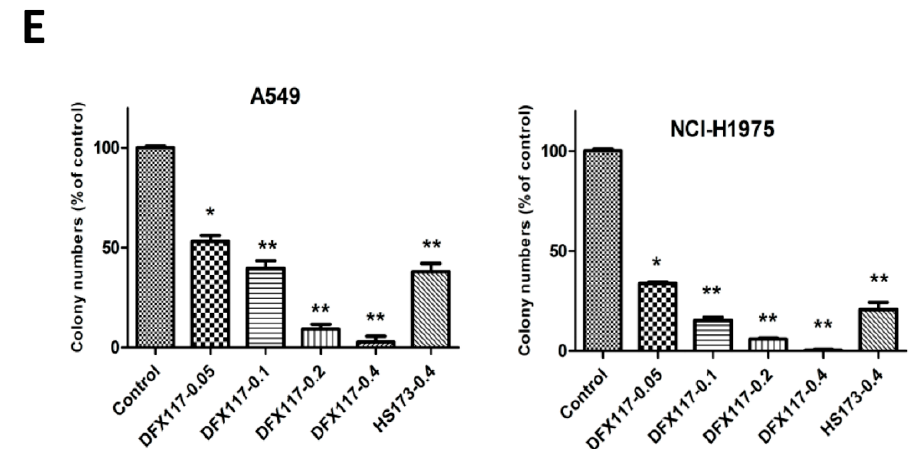
Figure 1. DFX117 significantly induces growth inhibition of non-small cell lung cancer cells. ( A ) The proliferation of four lung cancer cell lines (A549, NCI-H1975, PC9 and NCI-H1993) were significantly inhibited by DFX117. ( B ) DFX117 showed few effects on cell growth of normal cell lines MRC-5 at higher concentration. ( C ) The chemical structure of DFX117 and the IC 50 values of DFX117 against non-small cell lung cancer cells or normal cell lines. ( D ) Colony formation assays were performed in the A549 and NCI-H1975 cells treated with various concentrations of DFX117. 500 cells were plated in 6 wells plates and incubated for 12 h before treatment with DMSO or DFX117 at indicated concentration for 72 h. Then cells were then washed once with PBS and continue to culture with full-growth medium for 10 days, change the culture medium to fresh ones every three days. Cells were stained with 0.1% crystal violet after fixing with 100% methanol. ( E ) Representative images of the colony formation assay are depicted and compared with HS-173, a PI3K α inhibitor. * p < 0.05 or ** p < 0.01 was considered statistically significant compared with the corresponding control values.